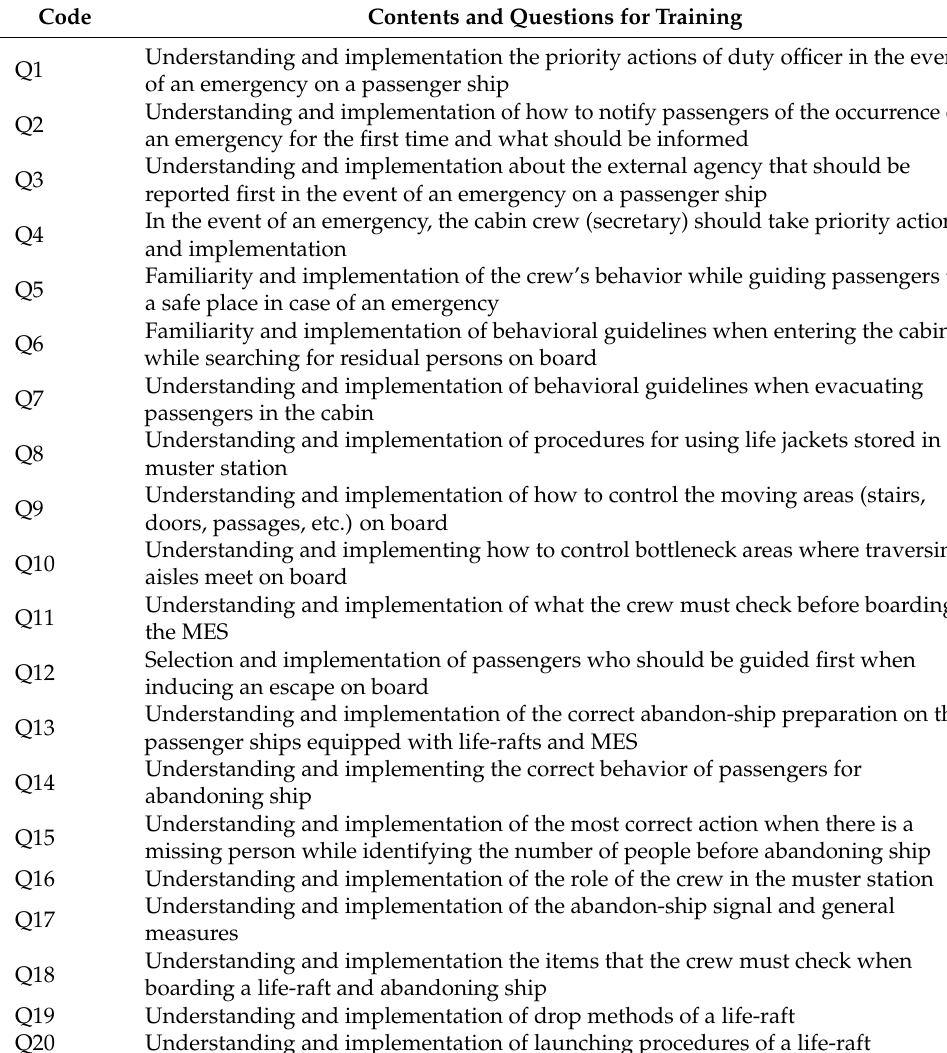
Table 2. Contents and examination questions of passenger ship crowd management